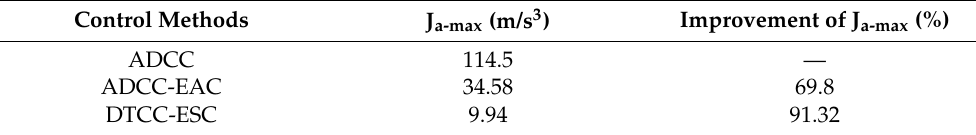
Table 4. Comparison Results of Jerks under Case